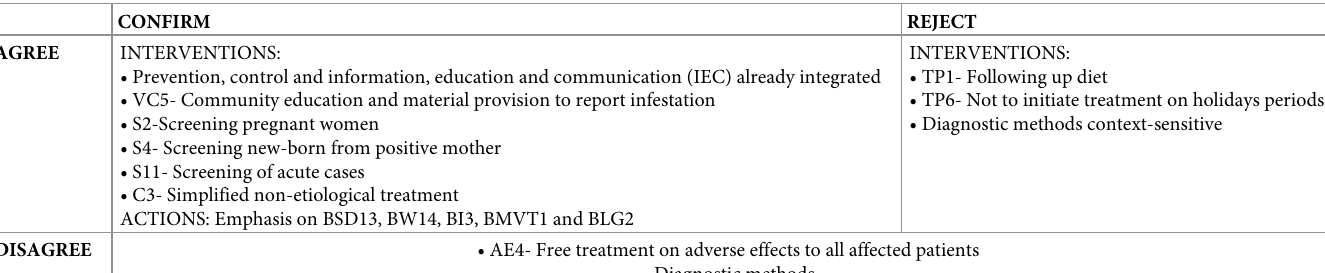
Table 2. Main discussion results with local